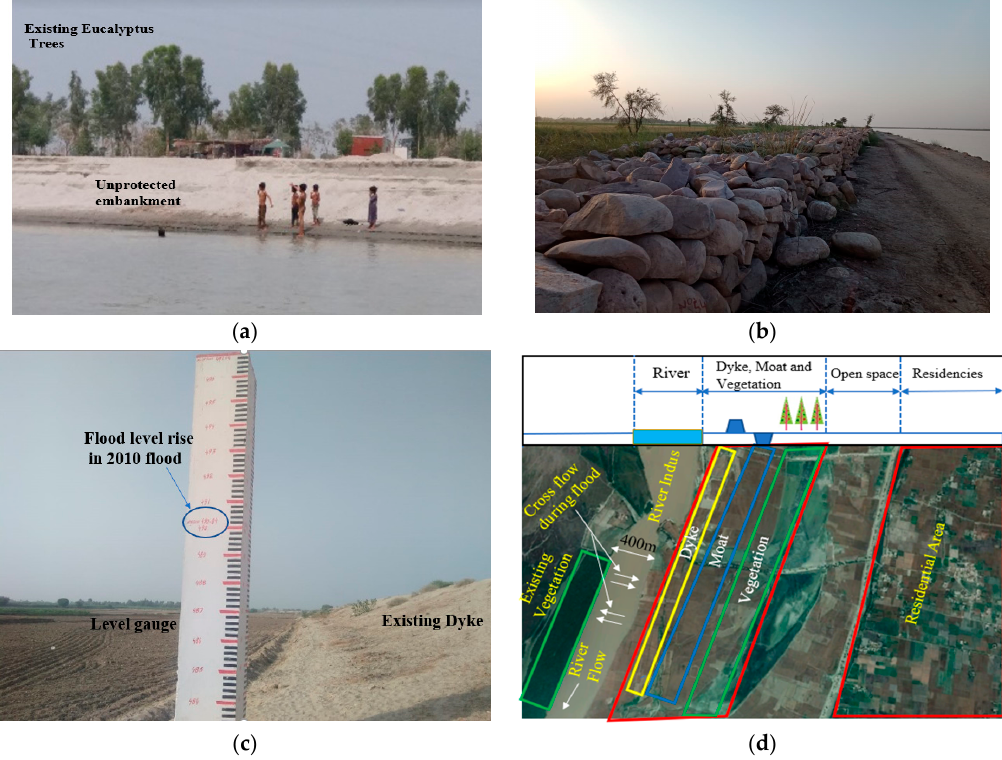
Figure 1. Pictorial views of the floodplain of Indus River near Taunsa Barrage. ( a ) Unprotected and scoured embankment. ( b ) Stone embankment protection. ( c ) Existing dike and level gauge. ( d ) Imagery of proposed hybrid defense system (HDS) at River Indus near Taunsa Barrage.